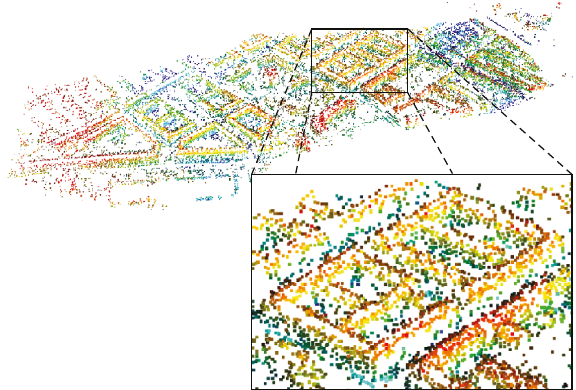
Figure 4: Calculated point cloud of an IR image sequence with the magnification of one building. The overall number of points is